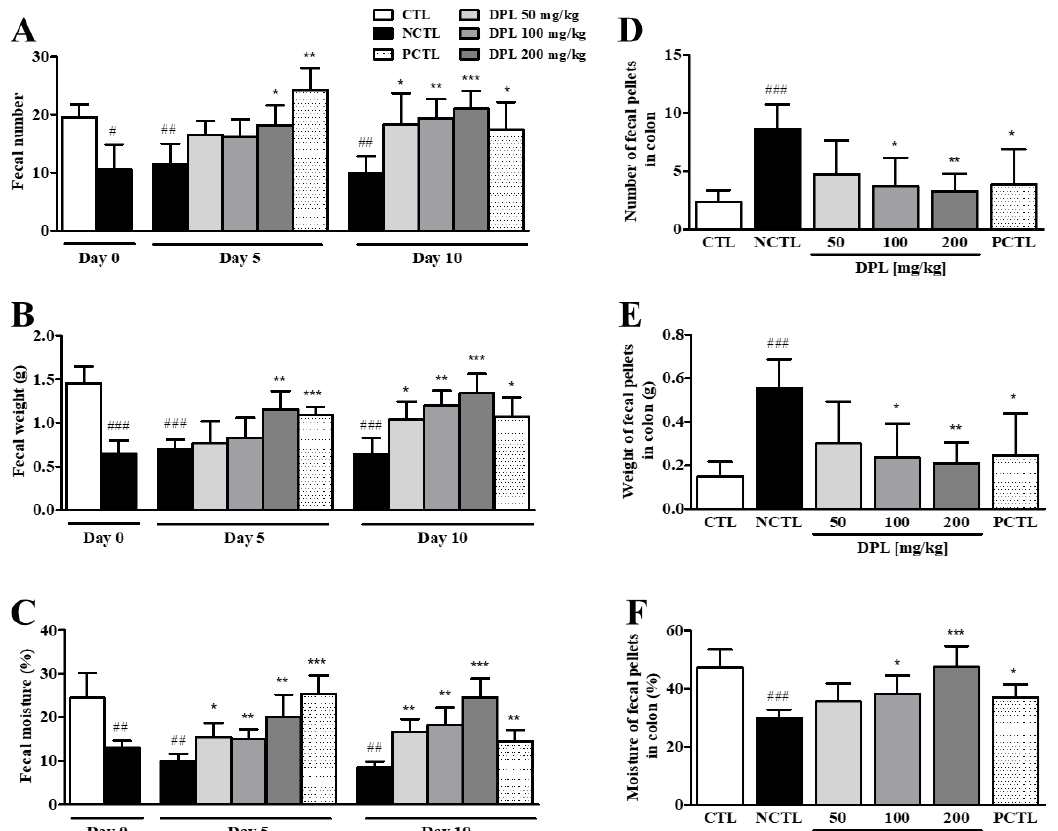
Figure 5. The laxative effects of D. morbiferus H. Lév. leaf extract (DPL) on low-fiber diet-induced constipation. At 0, 5, and 10 days, the total number ( A ), weight ( B ), and water content ( C ) of stools were measured. The stool water content was calculated using the fresh and dry weights of stools. At 10 days, the total number ( D ), weight ( E ), and water content ( F ) of stools contained in the intestines were measured. # Significant difference at p < 0.05, ## at p < 0.01, and ### at p < 0.001 compared with the control group (CTL). * Significant difference at p < 0.05, ** at p < 0.01 and *** at p < 0.001 compared with the low-fiber diet-induced constipation group (negative control group; NCTL).